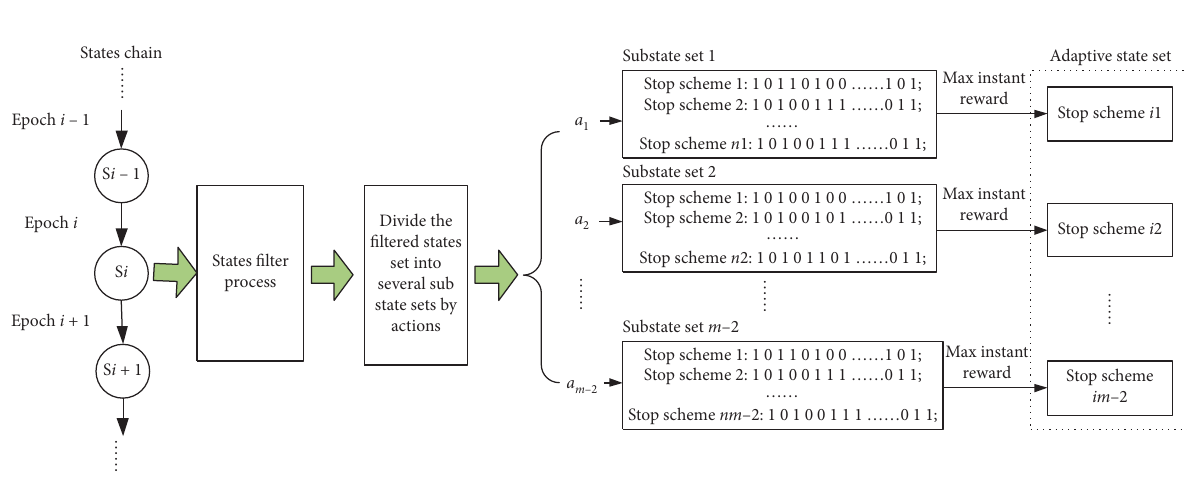
Figure 3: Generation process for adaptive state set in each epoch.